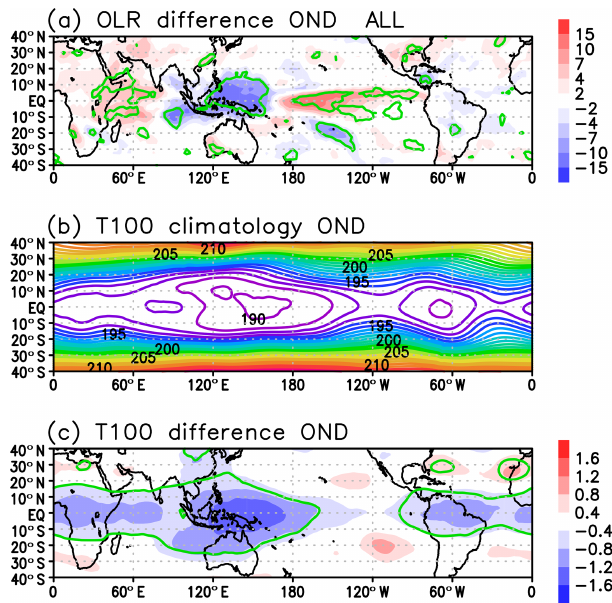
Figure 3. October–November–December (OND) mean OLR differ- ences between EQBO and WQBO winters. (b) OND-mean temper- ature at 100hPa averaged for the composite years. (c) OND-mean temperature difference between EQBO and WQBO winters. Green lines in panels (a) and (c) denote the statistically significant value at the 95% confidence level.